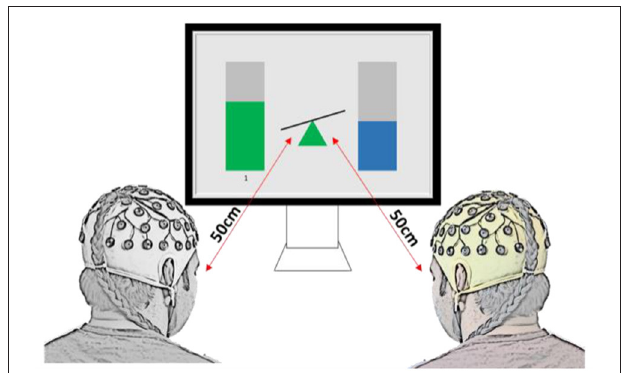
FIGURE 1 | Experimental setup and graphical user interface for the two-player BCI game, for both collaborative and competitive paradigms. In collaborative game, the task was to keep the seesaw in the middle in balance, while in the competitive game the task was to tilt it toward the player (as if being heavier in the physical